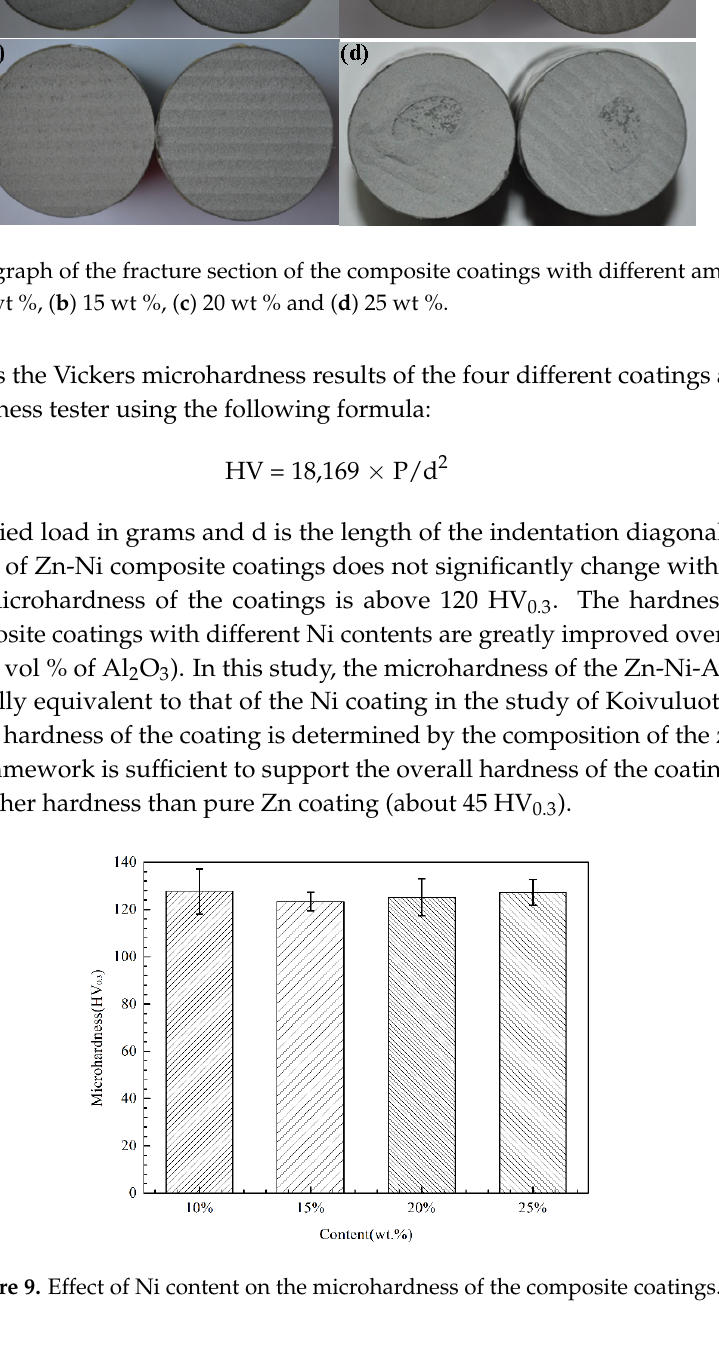
Figure 7. Influence of Ni content on the adhesion strength of coatings .